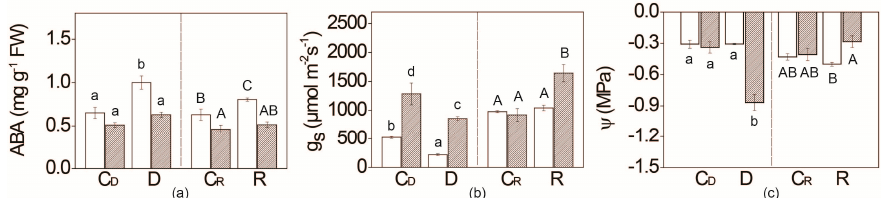
Figure 1. Content of ABA ( a ), values of stomatal conductance, g s, ( b ) and relative water potential, ψ ( c ), in the leaves of WT (white bars) and flacca (patterned bars) tomato genotypes subjected to six days of water deficit (D) period followed by a six day period of re-watering (R). Respective controls corresponding to water deficit condition (C D ) and re-watering (C R ) are presented. Values are presented as means ± SE ( n ≥ 4). Di ff erent letters denote significant di ff erences between means according to Tukey HSD post hoc test p ≤ 0.05. Small letters represent the di ff erences in means of drought treatment, while capital letters represent re-watering